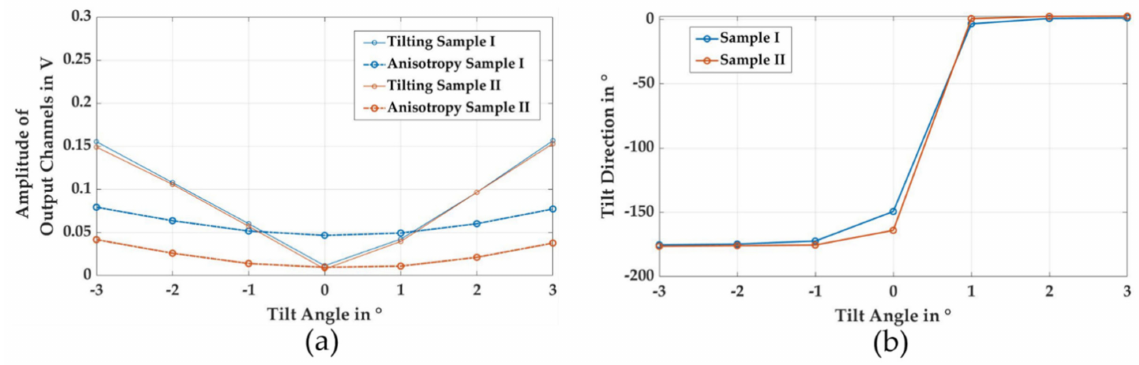
Figure 8. Output of the sensor systems after second Fast Fourier Transform (FFT): ( a ) Tilting and anisotropy for sample I and sample II as functions of the tilting angle. ( b ) Tilting direction as a function of the tilting angle for sample I and sample